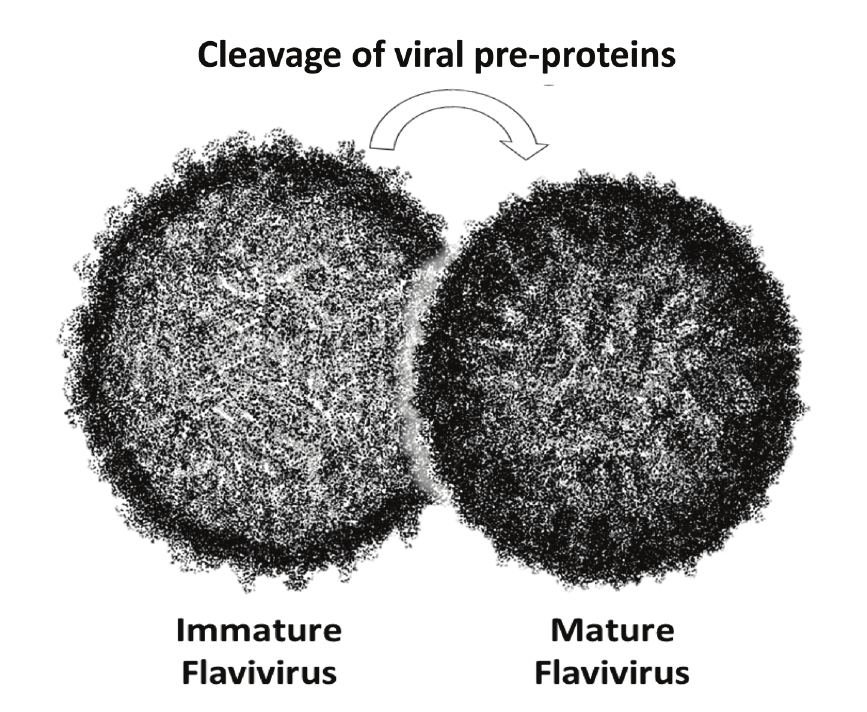
Figure 6. Model of immature and mature flavivirus. Predictive modeling based on published crystal- lographic reports of immature flaviviruses and the mature ZIKV virus protein structure, demonstrating that the visual appearance of immature flavivirus virions is less dense, and contains a “thin coat” versus the dense, “thick coat” of a mature flavivirus. These models are similar to the images collected for HC and trophoblast supernatants +/- ruxolitinib, wherein virions from HC and trophoblasts without ruxolitinib generated immature virions, and virions grown in HC and trophoblasts in the presence of ruxolitinib pro- duced mature virions (Figure